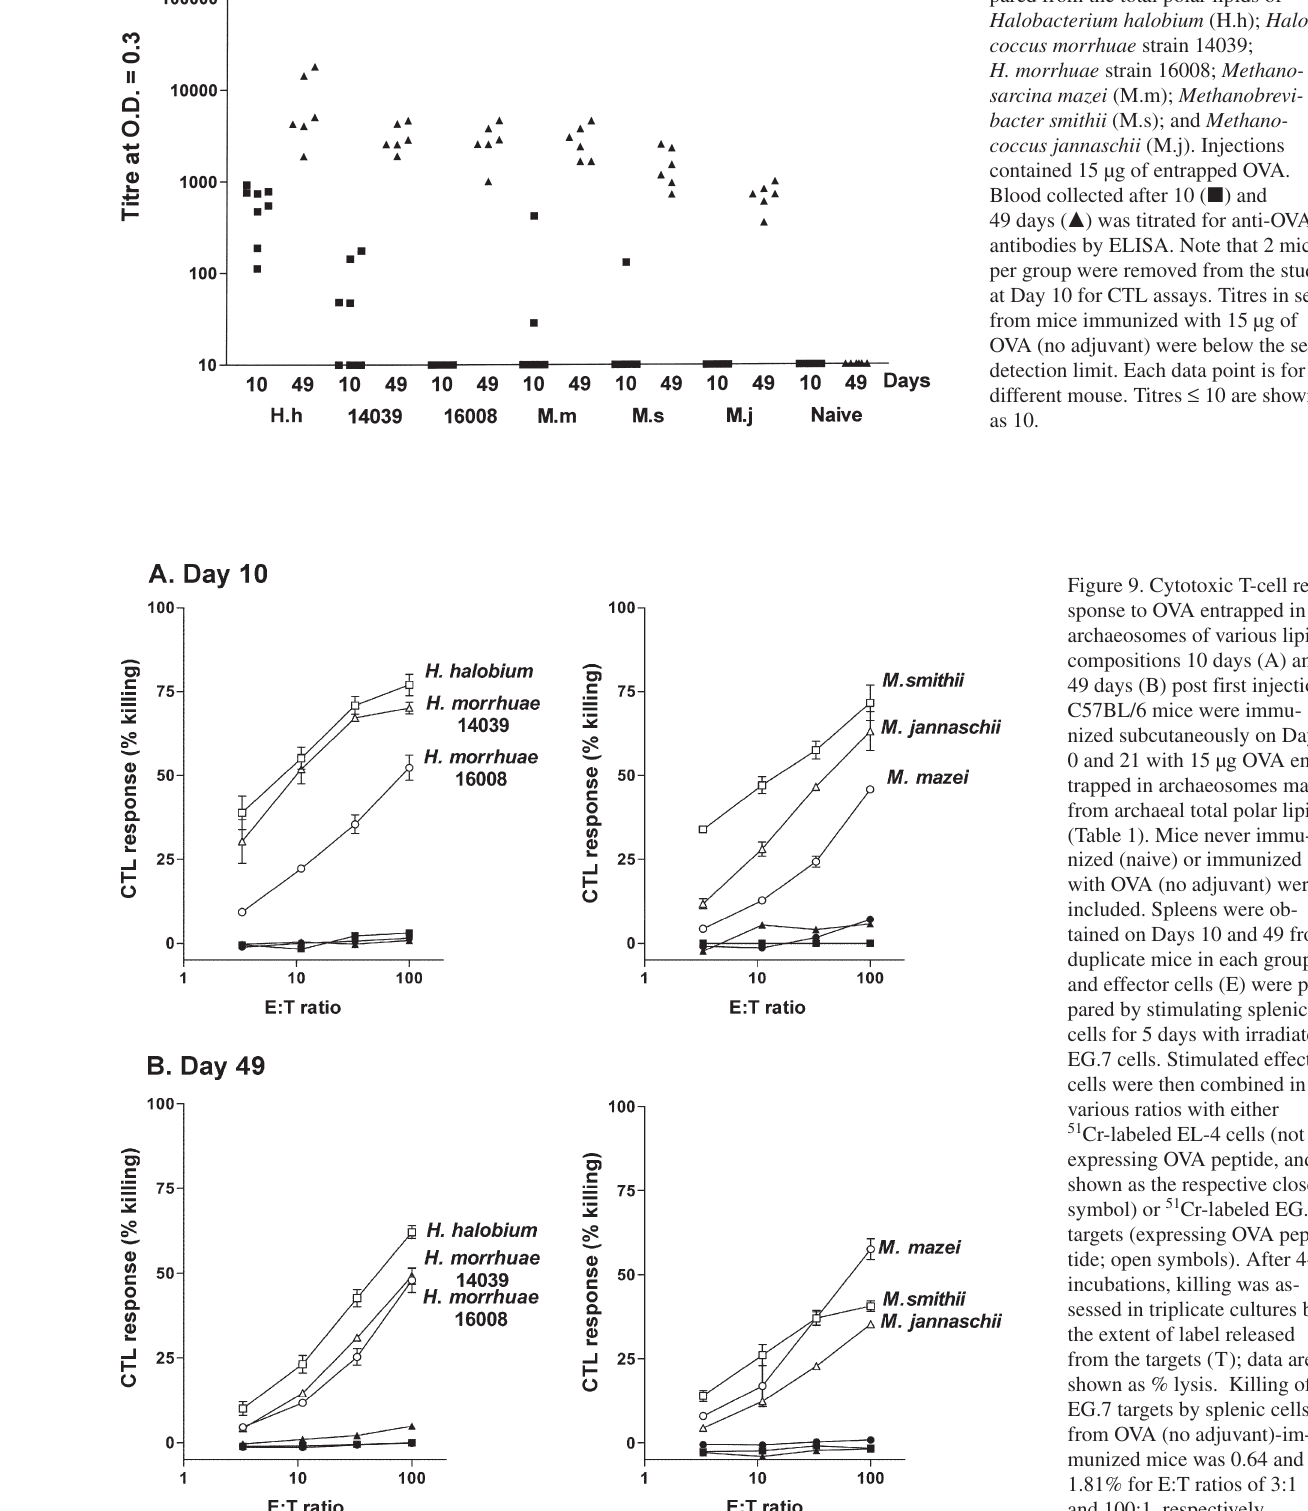
Figure 8. Effect of total polar lipid com- position on humoral adjuvant activity of OVA-archaeosomes. C57BL/6 mice were immunized subcutaneously at 0 and 21 days with archaeosomes pre- pared from the total polar lipids of Halobacterium halobium (H.h); Halo- coccus morrhuae strain 14039; H. morrhuae strain 16008; Methano- sarcina mazei (M.m); Methanobrevi- bacter smithii (M.s); and Methano- coccus jannaschii (M.j). Injections contained 15 µg of entrapped OVA. Blood collected after 10 ( (cid:2) ) and 49 days ( (cid:3) ) was titrated for anti-OVA antibodies by ELISA. Note that 2 mice per group were removed from the study at Day 10 for CTL assays. Titres in sera from mice immunized with 15 µg of OVA (no adjuvant) were below the set detection limit. Each data point is for a different mouse. Titres ≤ 10 are shown as 10.